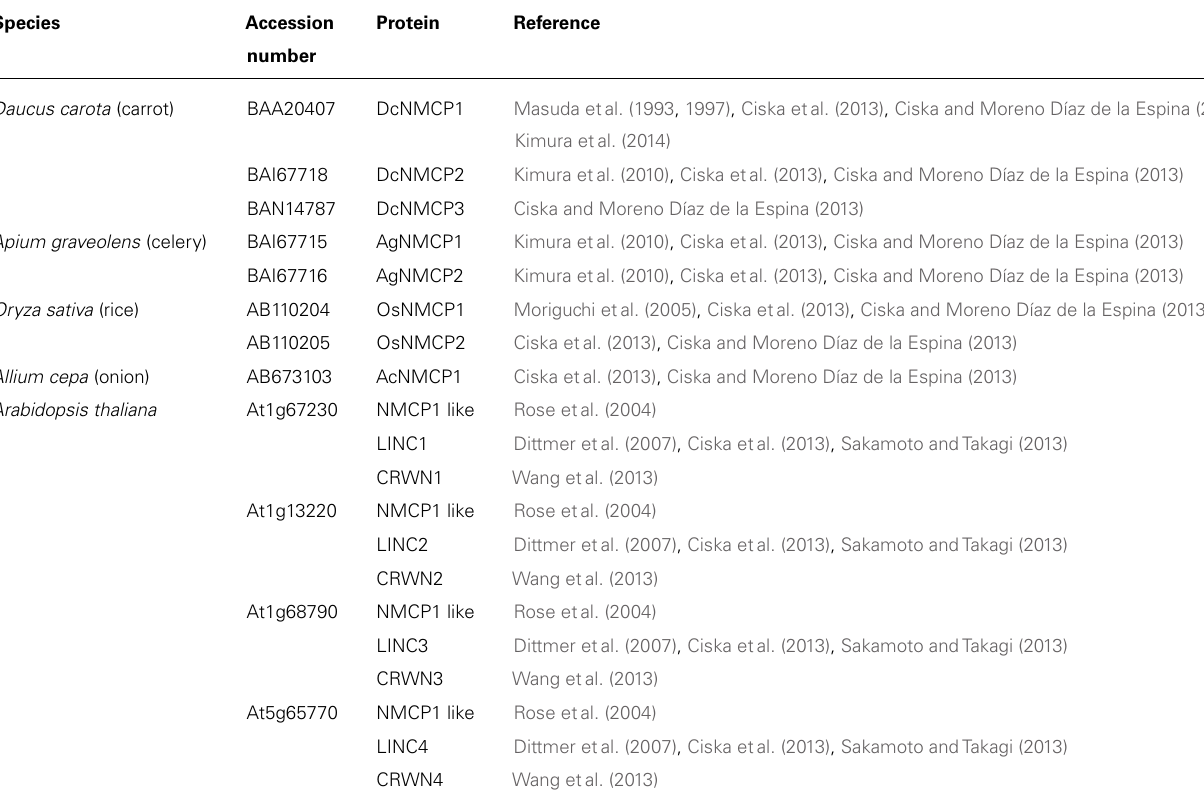
Table 1 |Terminology used for NMCP proteins reported in different plant